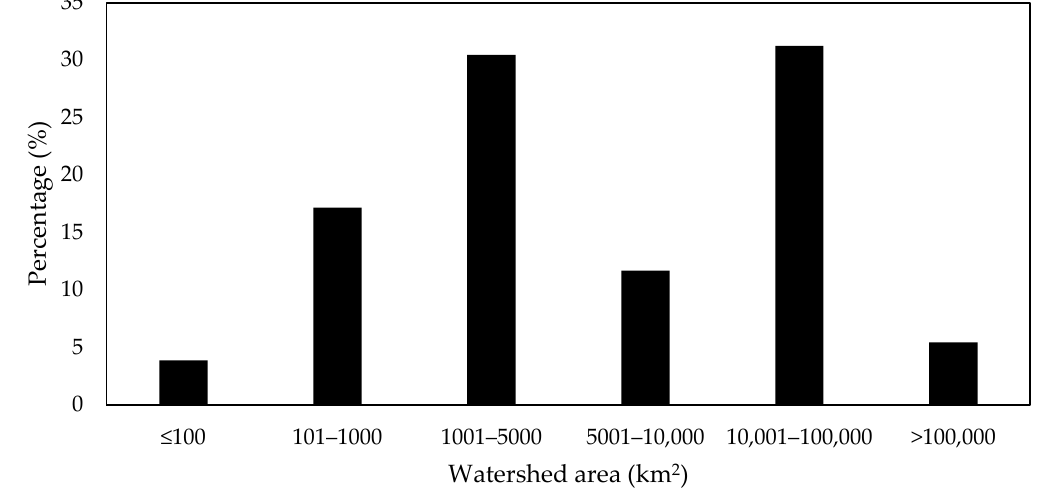
Figure 3. Watershed size of SWAT studies in Southeast Asia. Table 2. Summary of reported SWAT model performance in streamflow simulations in Southeast Asia.